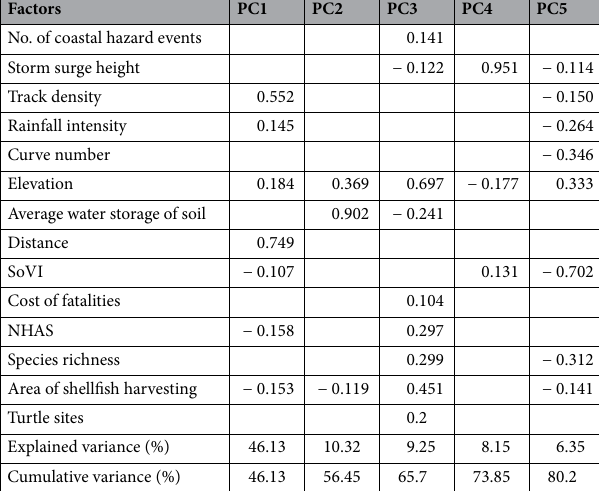
Table 6. Results of factors loading after varimax rotation.